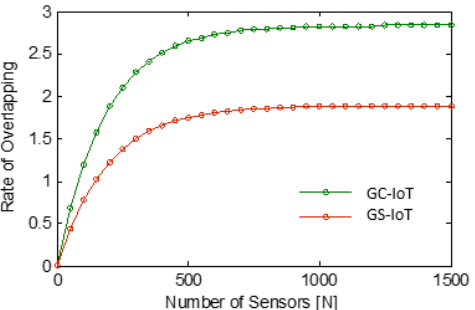
Figure 15. A better difference visibility of overlapping rate.